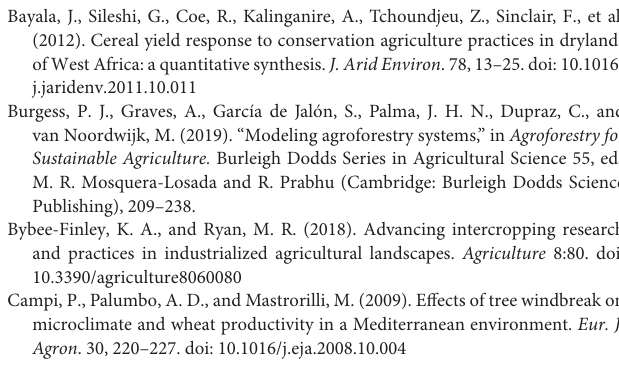
Supplementary Figure 1 | Advantages and constraints associated with agroforestry systems in comparison to monocultures. Supplementary Figure 2 | Ecological interactions and potential effects on species. + and − denote positive and negative effects, respectively. 0 denotes no effect (adapted from Jose et al.,